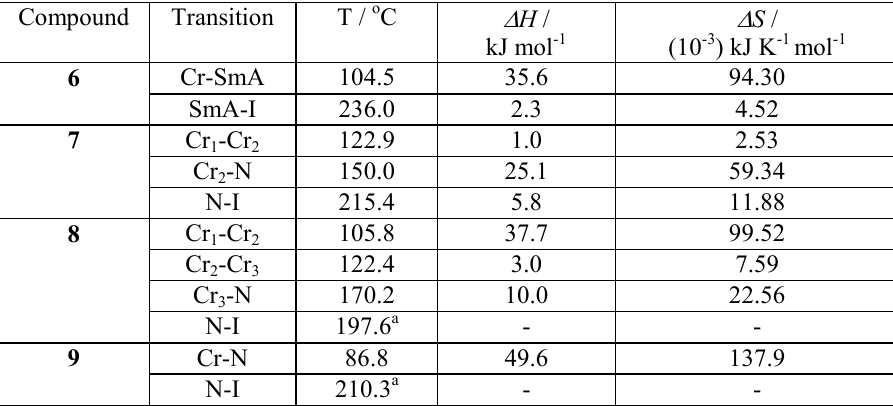
Table 1. Transition Temperatures, Associated Enthalpy and Entropy Changes of Compounds